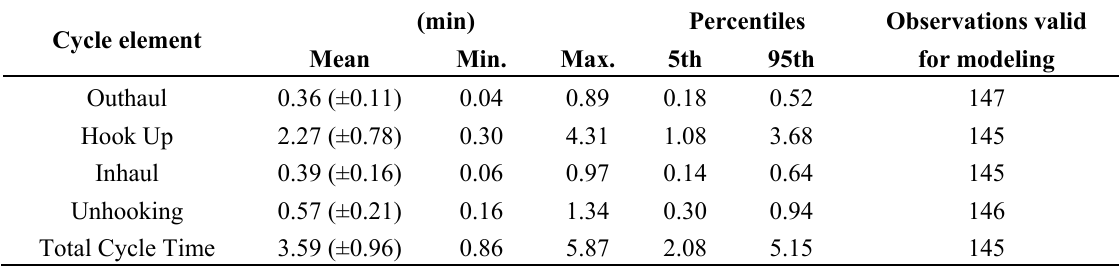
Figure 2. Total time distribution of the survey among cycle elements in dependence of delay time consideration. With ( a ) considering the time distribution among the cycle elements and all occurring delay times; ( b ) considering the time distribution among the cycle elements and the share of delay times < 15 min only; and ( c ) considering the time distribution among the cycle elements without delay times. Table 6. Descriptive statistics of the PMH 0 (productive machine hours excluding delay times) cycle element times with standard deviations (in parentheses), the percentile threshold for validity, and the number of observations valid for modeling through regression